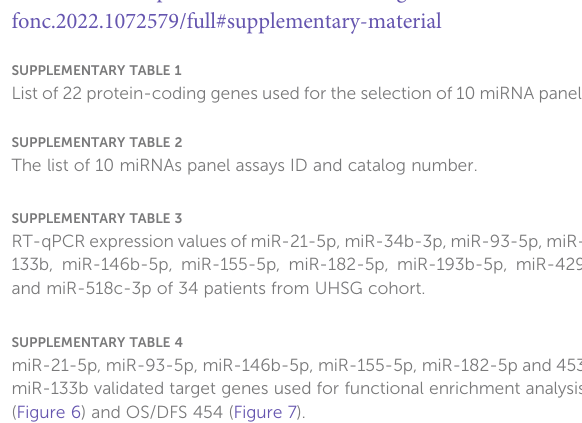
SUPPLEMENTARY TABLE 1 List of 22 protein-coding genes used for the selection of 10 miRNA panel. SUPPLEMENTARY TABLE 2 The list of 10 miRNAs panel assays ID and catalog